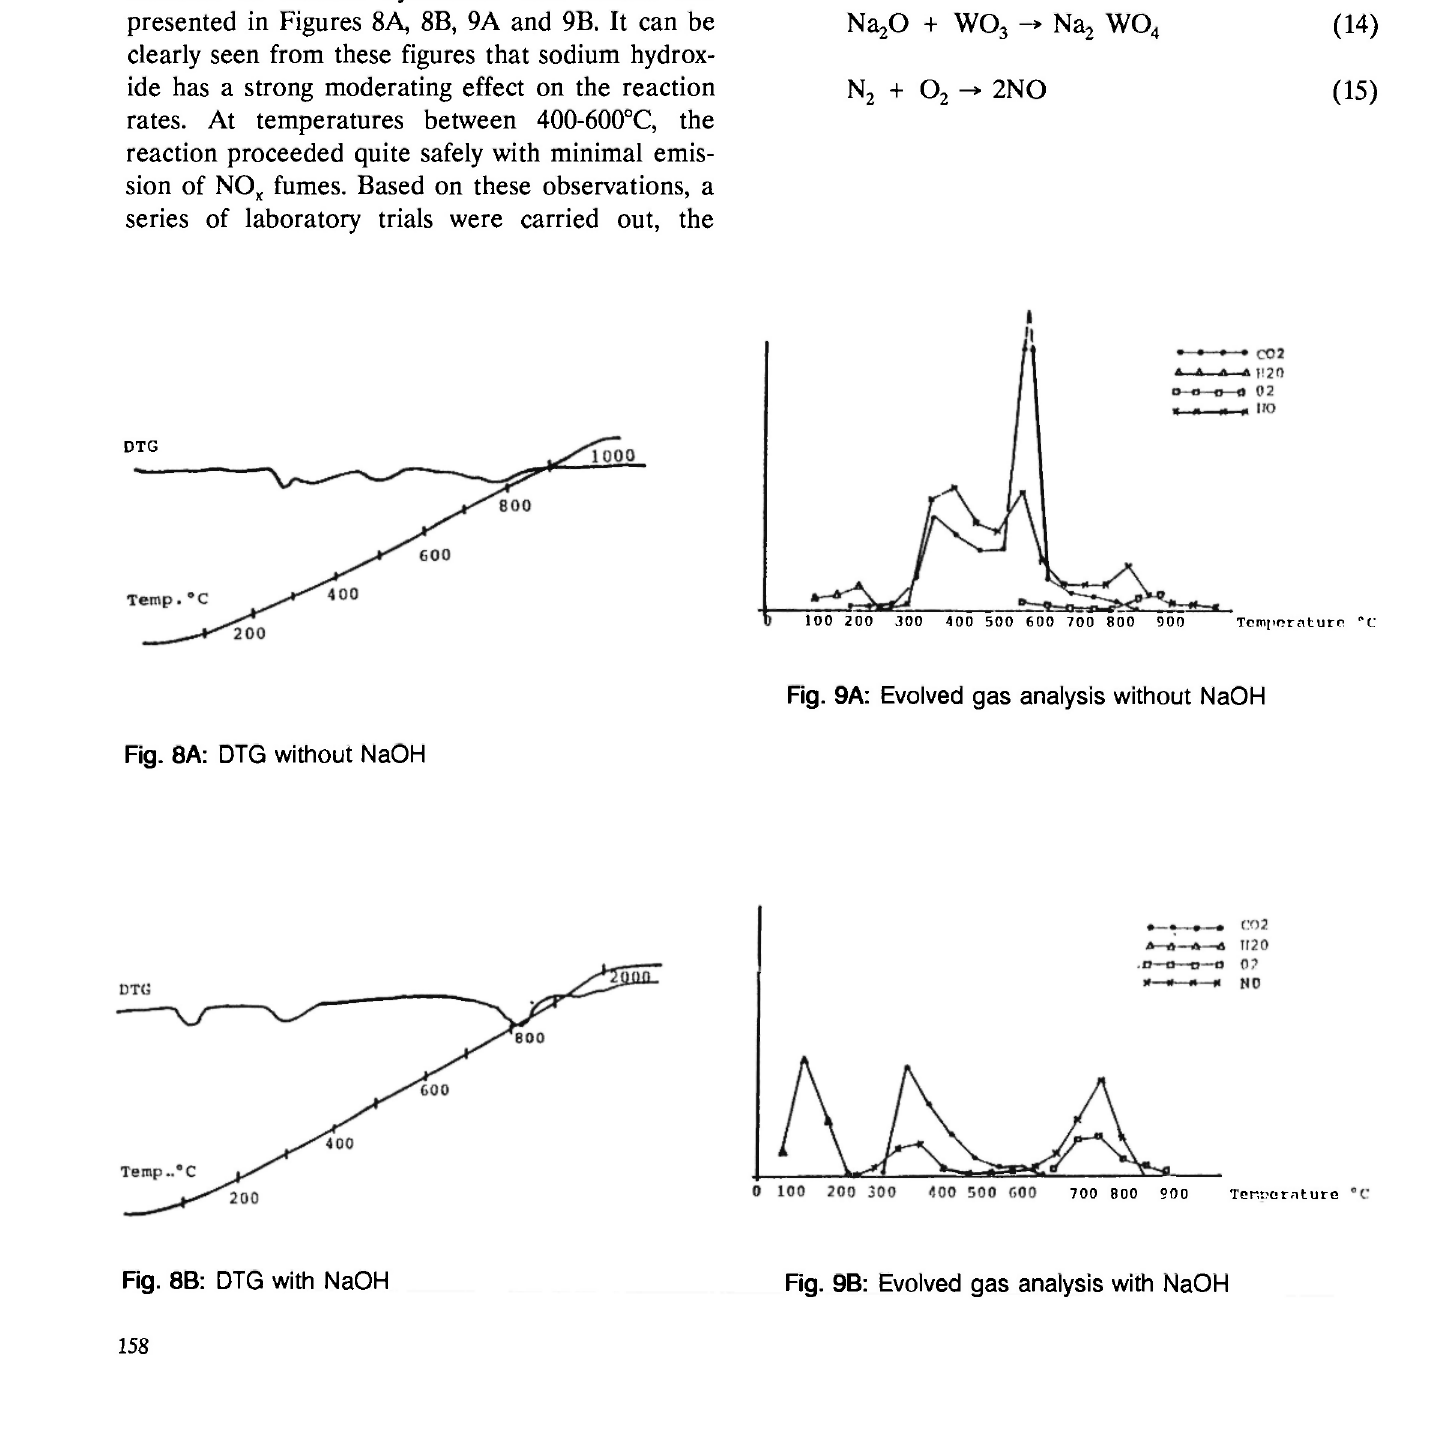
Fig. 8A: DTG without NaOH